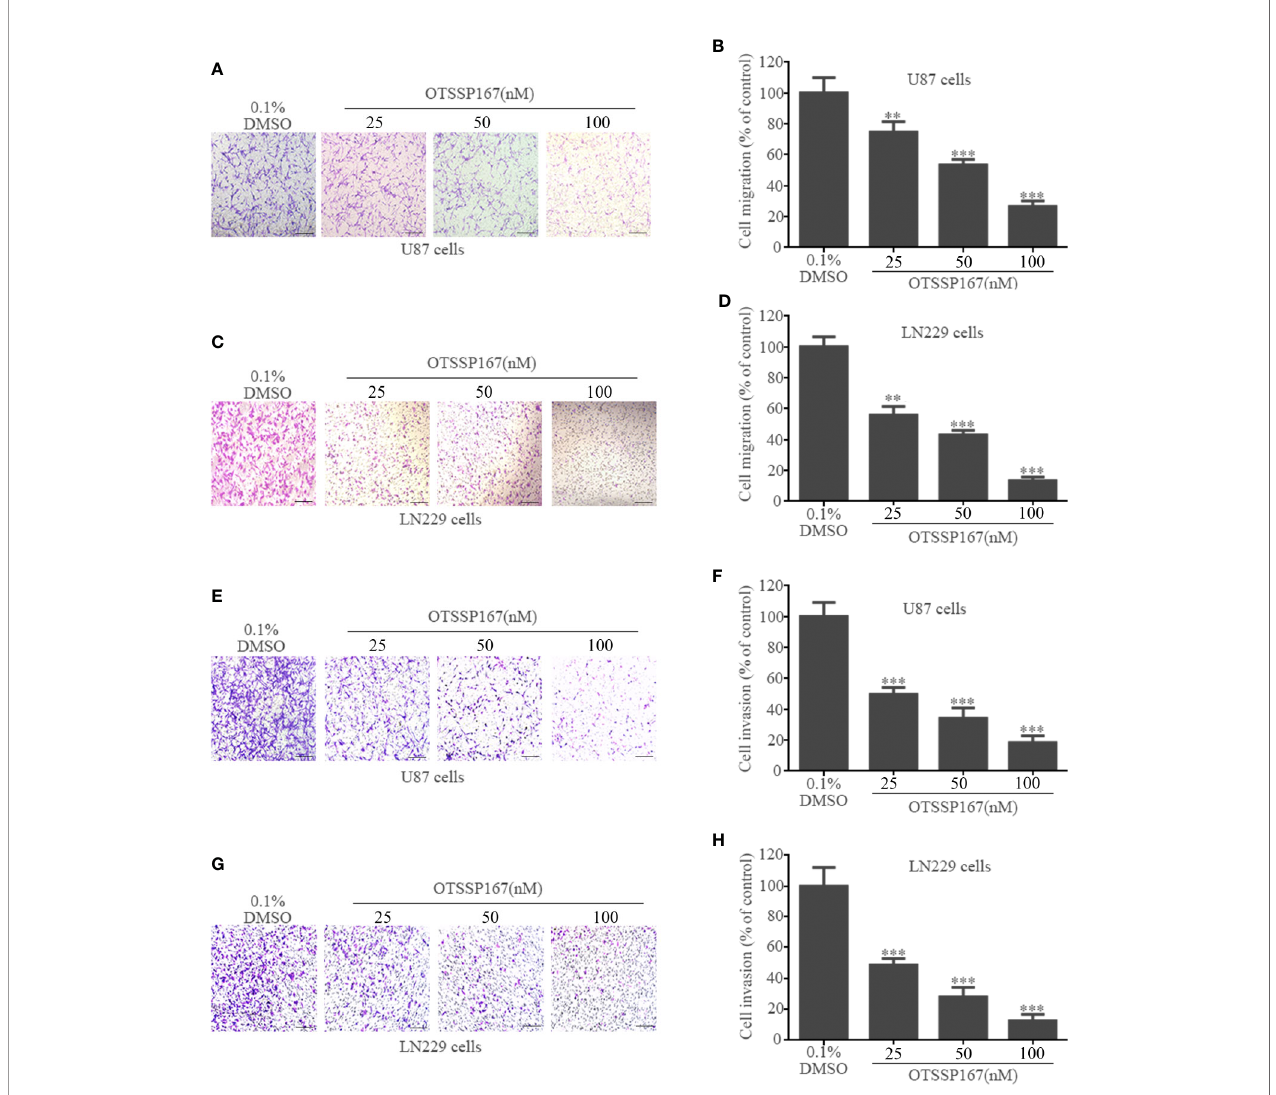
FIGURE 3 | OTSSP167 inhibit GBM cell migration and invasion. U87 and LN229 cells were treated with 0 – 100 nM OTSSP167 for 24 h, followed by Transwell migration assay ( A – D , no Matrigel) and invasion assay ( E – H , addition of Matrigel). All the Data are presented as means ± SEM. ** P < 0.01, *** P < 0.001 compared with the 0.1% DMSO treated